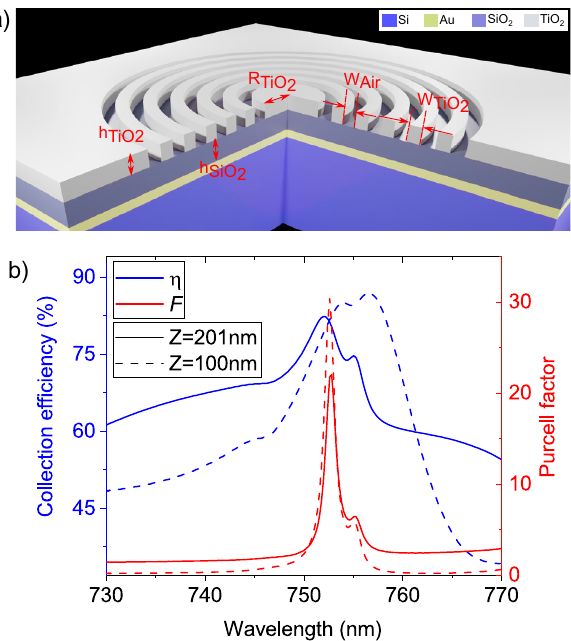
Figure 1. Bullseye dielectric cavity structure. ( a ) 3D representation of the structure, consisting of TiO 2 rings on a SiO 2 layer, above a gold mirror. The key dimensions of the structure are labelled. A dipole emitter is in the middle of the central disc. ( b ) Collection efficiency (left y-axis) and the Purcell factor (right y-axis) as a function of the wavelength for a 10 ring-pair cavity designed for 752 nm. Calculation performed with = 280 nm . The height of the dipole above the surface of the silica is = 835 nm, W Air = 140 nm, W TiO R TiO 2 2 given by